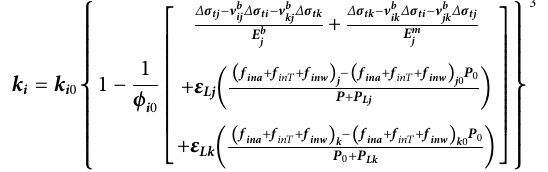
The permeability of the cubic sample under different CO 2 injection pressures and con fi ning pressures is shown in Figure 5. As a whole, the variation trends of permeability in either direction with con fi ning pressure and CO 2 injection pressure are coincident, this indicates that the in fl uence of the effect stress on the seepage capacity of face cleat, butt cleat and bedding plane fracture is analogous. However, the permeability measured in different directions shows distinct anisotropic characteristics. The ratios of k x : k y : k z are 1.53:1.35: 1, 1.58:1.42:1, 1.58:1.33:1, and 1.61:1.43:1 respectively, e.g.,